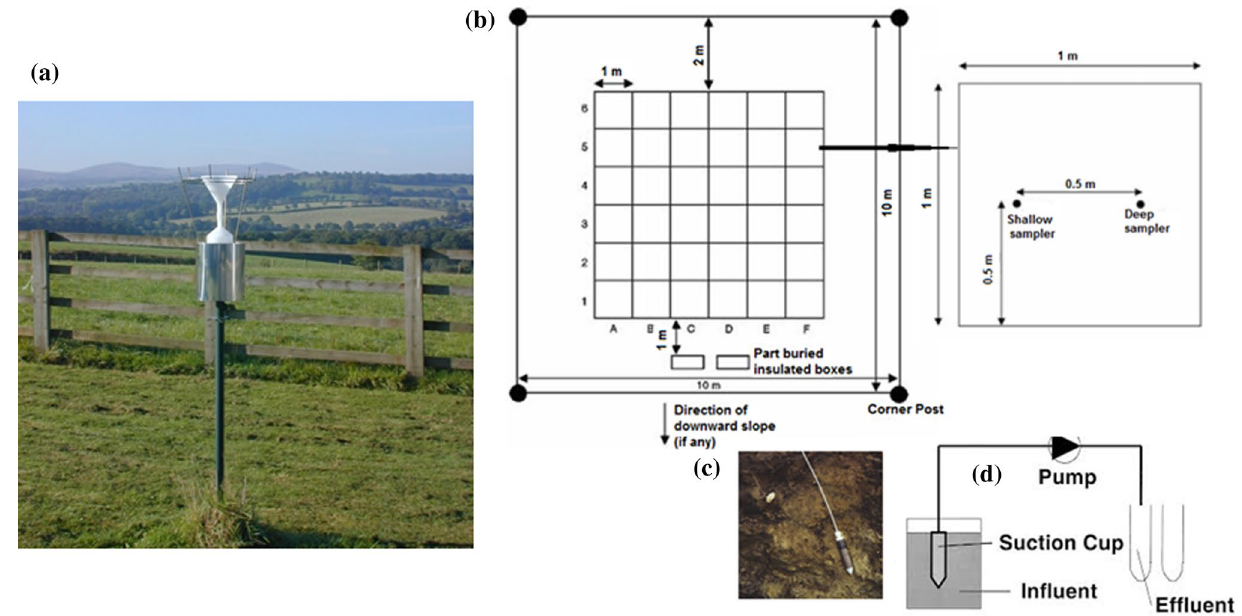
Fig. 2 Field instrumentation a is bulk precipitation collector. b – d show the site, physical appearance and mechanism of the soil water collector,